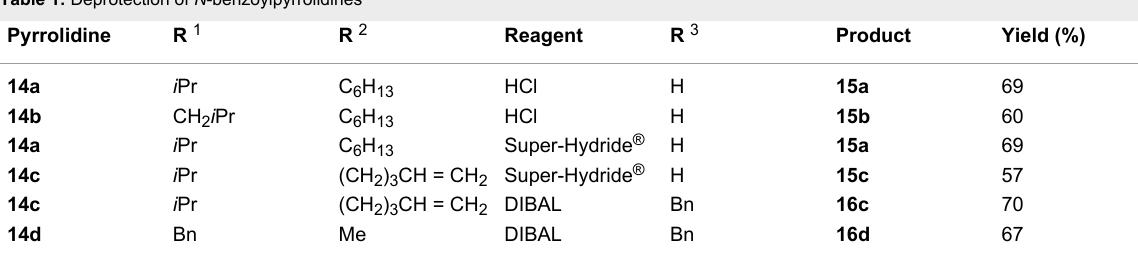
Table 1: Deprotection of N -benzoylpyrrolidines Pyrrolidine